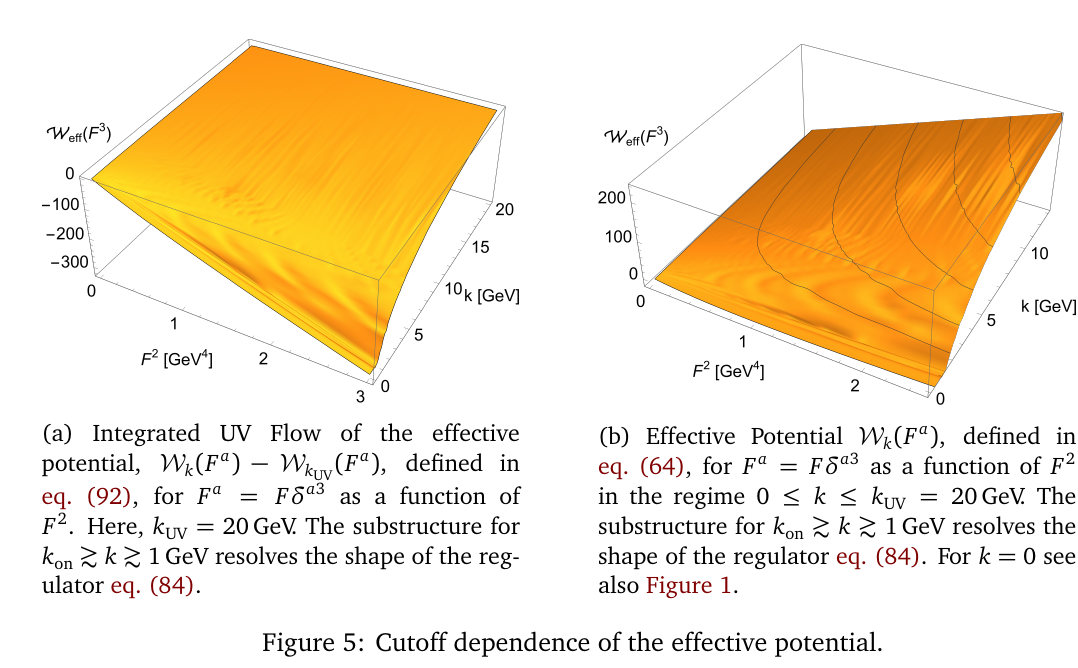
Figure 5: Cutoff dependence of the effective